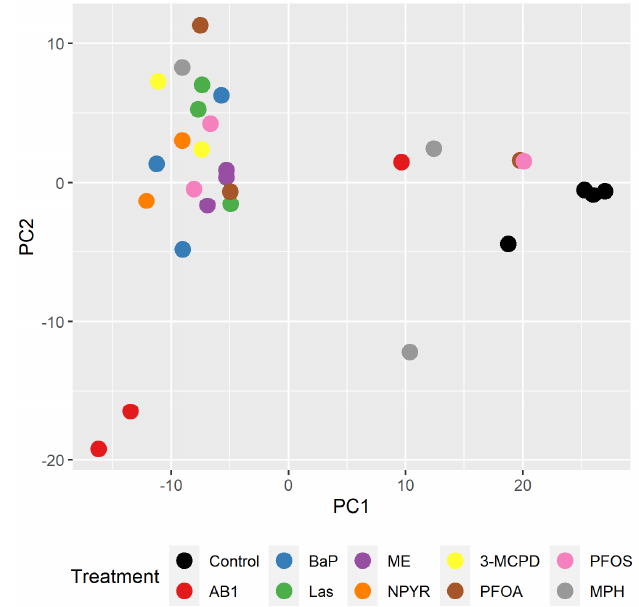
Figure 5. Principal Component Analysis (PCA) scores plot of transcriptome profiles for individual samples. To establish the criteria for a clear separation between GTX and NGTX compounds in TK6 cells after incubation with genotoxins AB1, BaP, Las, ME, or NPYR or with non-genotoxins 3-MCPD, MPH, PFOA, or PFOS for RNA sequencing, a PCA scores plot was created as a first attempt. PCA scores reflecting the overall structure of gene expression were performed for a subset of significant DEGs based on normalized variance-stabilized read counts. Each treatment is indicated by an individual color. Only controls cluster together, so a finer separation analysis is necessary.